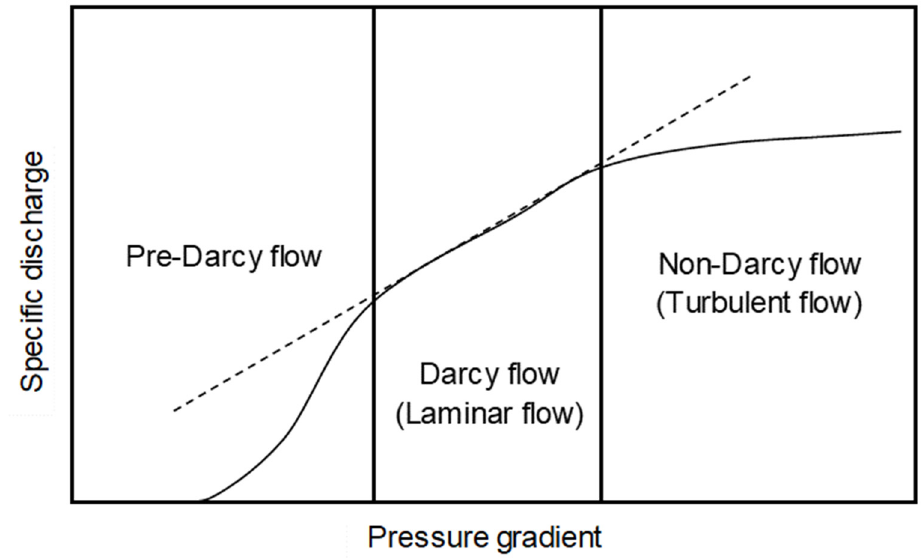
Figure 5. Schematic representation of flow regimes in a porous medium. The broken line follows Darcy’s law. This figure is modified from Basak [37] and Macini et al. [40].